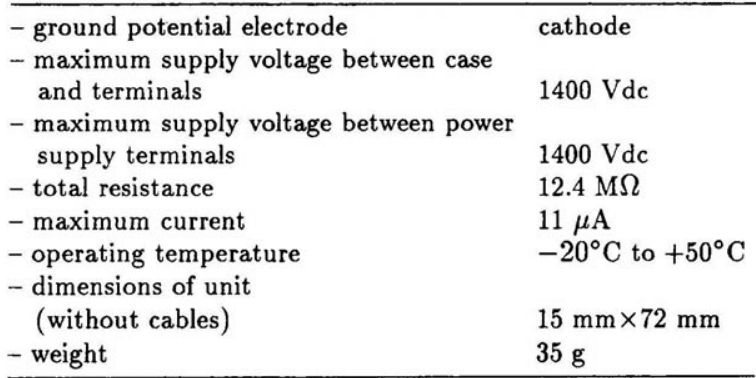
Table 1. The main specifications of the D 303 type